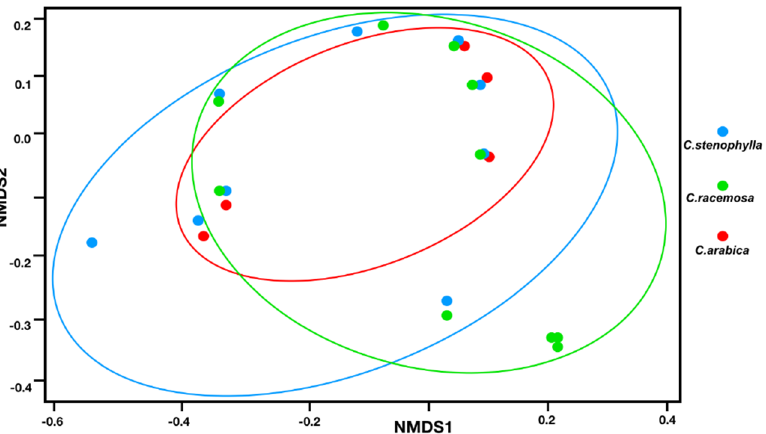
Figure 3. Beta diversity analysis using nonmetric multidimensional scaling (NMDS) plots based on Bray–Curtis dissimilarity of discriminating genera in the phyllosphere of C. stenophylla (blue line), C. racemosa (green line), and C. arabica (red line).